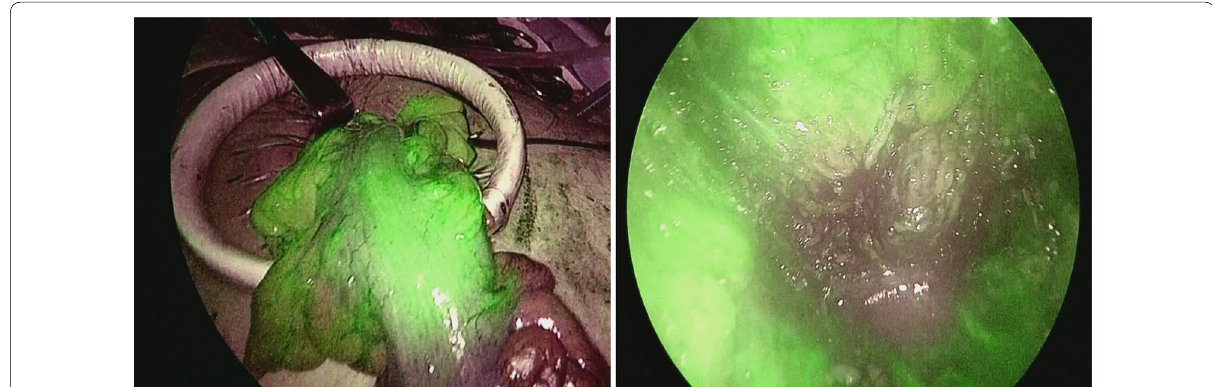
Fig. 7 During the creation of the anastomosis, indocyanine green-based fluorescence imaging was used to confirm that intestinal blood flow had been preserved (we administered 12.5 mg of ICG and confirmed that the anastomosis was contrasted in 27 s). The left side is the indocyanine green-based fluorescence imaging of the oral side of the anastomosis, while the right side shows that of the anal side of the